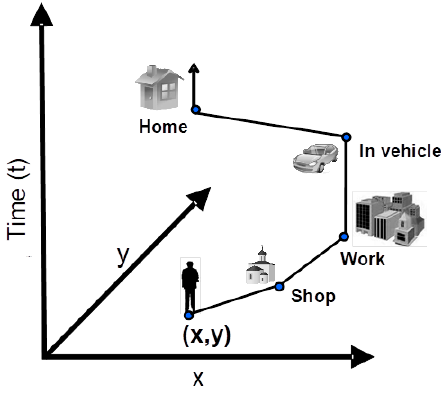
Figure 1. Trajectory of an individual in space (x, y) and time (t).